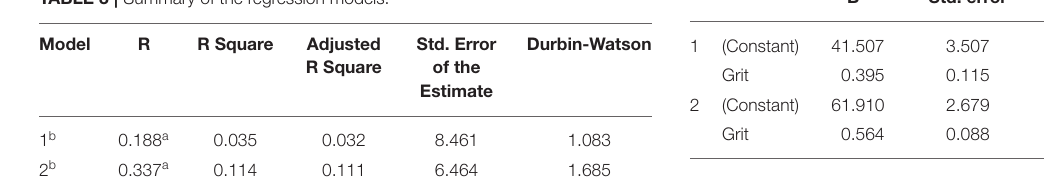
TABLE 3 | Summary of the regression models.